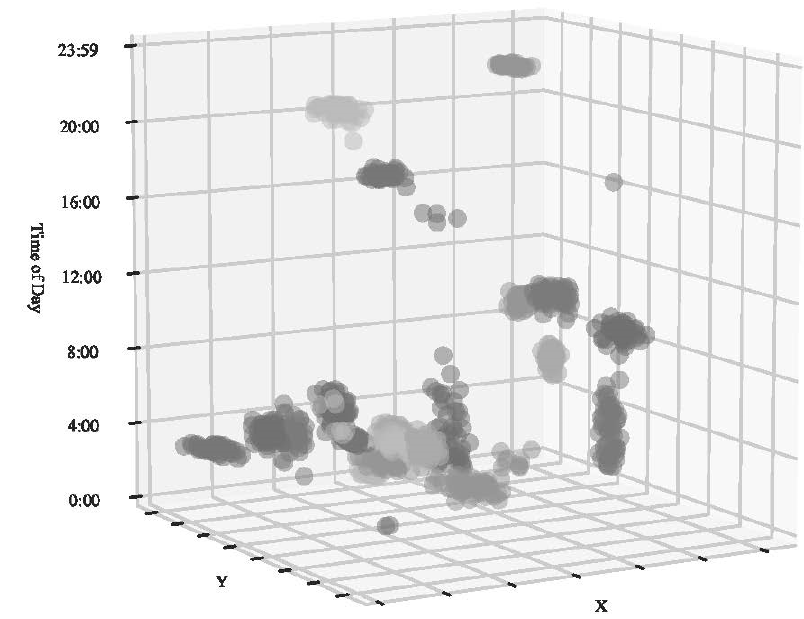
Figure 5. Simulated dataset that is used for comparing di ff erent clustering